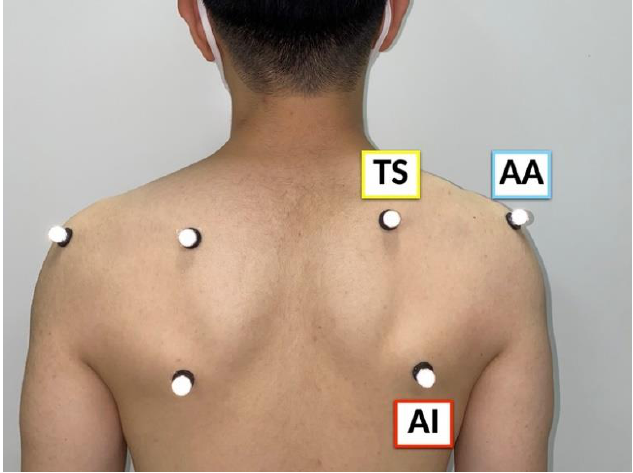
Figure 2. Skin markers were attached to the acromial angle (angulus acromialis [AA]), root of the scapular spine (trigonum spinae scapulae [TS]), and inferior angle (angulus inferior [AI]) of the participants.